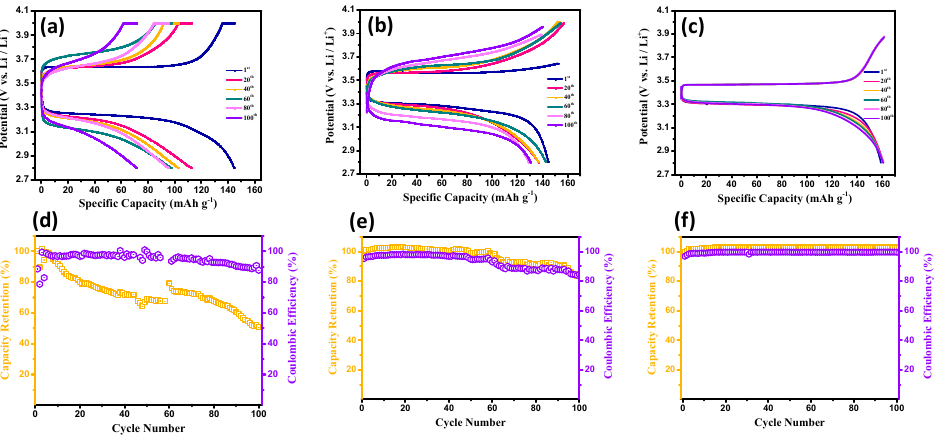
Figure 4. Typical charge–discharge curves and cyclic performance of the test cells equipped with different CSEs, where the LiTFSI/LATP ratios were 1.5 ( a , d ), 1.8 ( b , e ), and 2.0 ( c , f ).